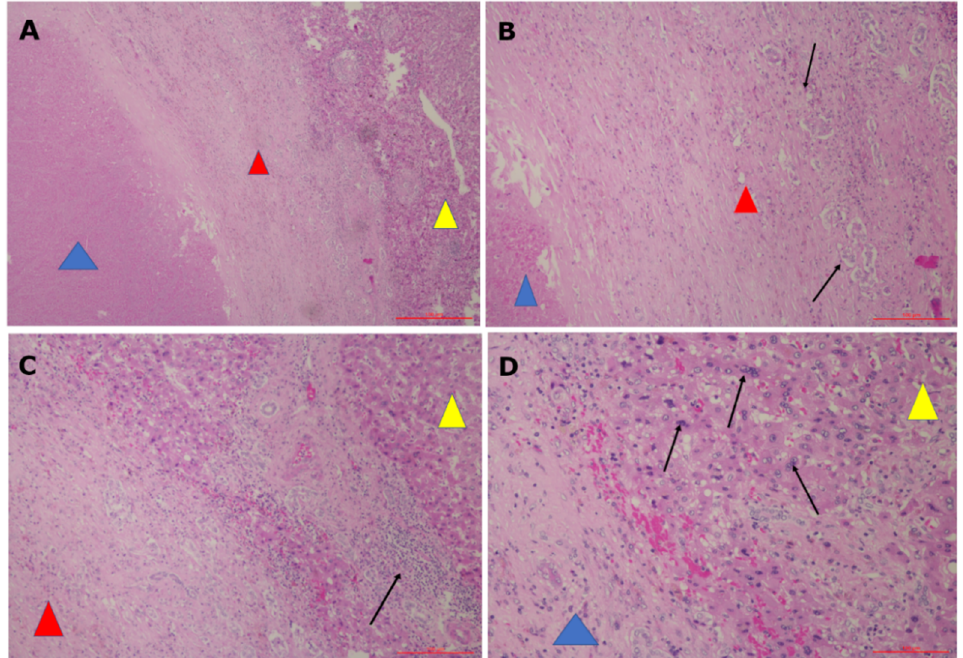
Figure 8. Ablated colorectal liver metastasis and liver parenchyma after ECT (6 weeks after treatment). ( A ) H&E 5 × . Blue triangle: necrosis, Red triangle: pseudocapsule, Yellow triangle: liver parenchyma. ( B ) H&E 20 × . Blue triangle: necrosis, Red triangle: pseudocapsule, Arrows: bile duct proliferation. ( C ) H&E 10 × . Red triangle: pseudocapsule, Yellow triangle: liver parenchyma, Arrow: chronic inflammation. ( D ) H&E 20 × . Blue triangle: pseudocapsule, Yellow triangle: liver parenchyma, Arrows: regeneratory changed hepatocytes.